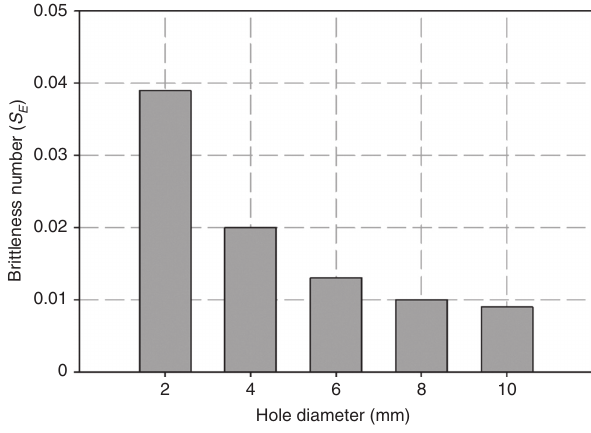
Figure 10 Specimen size effect on brittleness number for [0/45/90/-45] . s